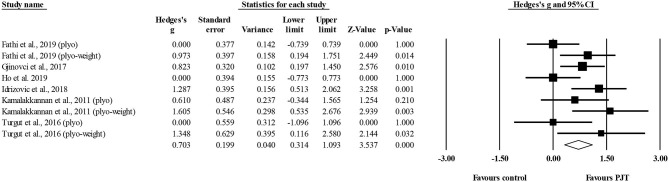
Forest plot of changes in linear sprint performance in volleyball players participating in plyometric jump training (PJT) compared to controls. Values shown are effect sizes (Hedges's g) with 95% confidence intervals (CI). The size of the plotted squares reflects the statistical weight of the study.